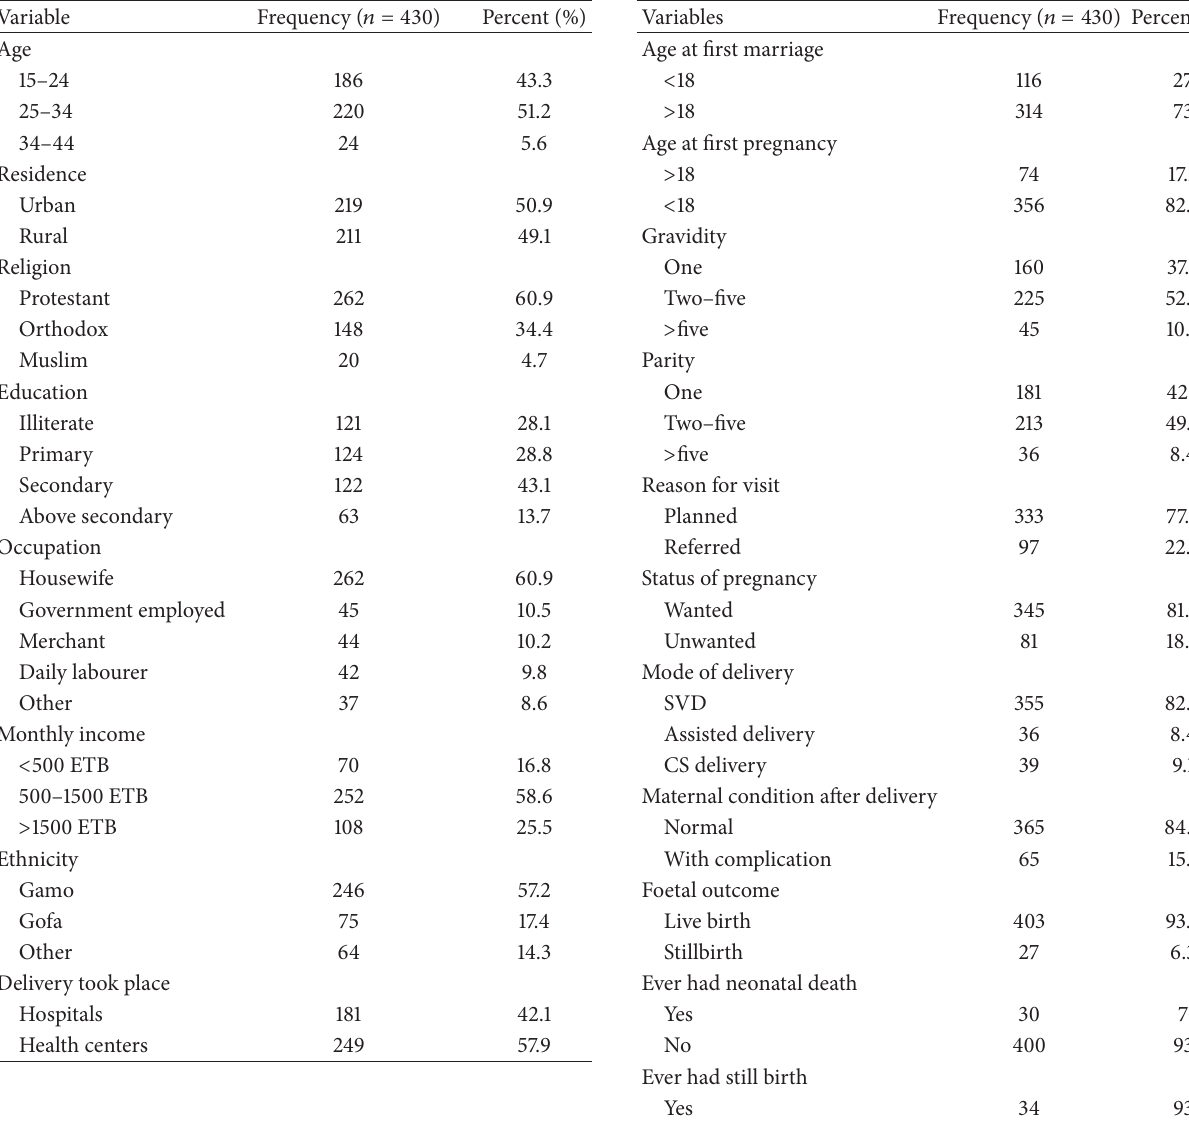
Table 1: Sociodemographic characteristic of respondents in public health facility of Gamo Gofa Zone, southwest Ethiopia, May 2014.